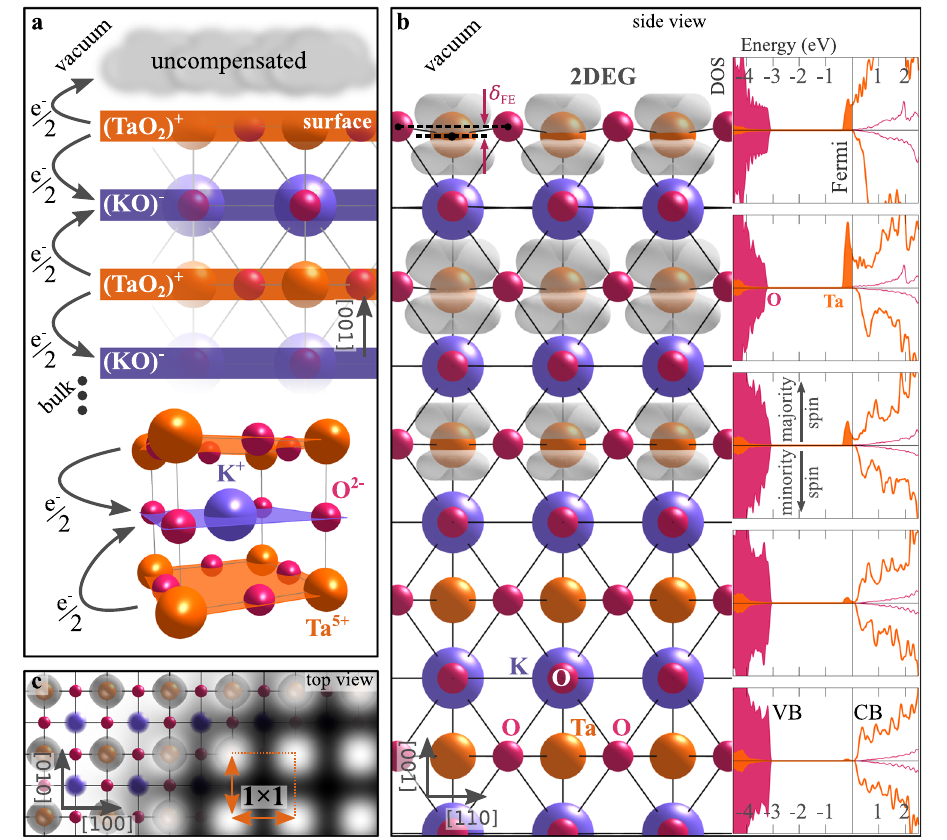
Fig.2|2DEGonthepolarKTaO 3 surface.a PictorialviewoftheperovskiteKTaO 3 , sketchingthebulkprimitivecellwiththeformaloxidationstateofatoms(bottom), andthe(KO) − and(TaO 2 ) +